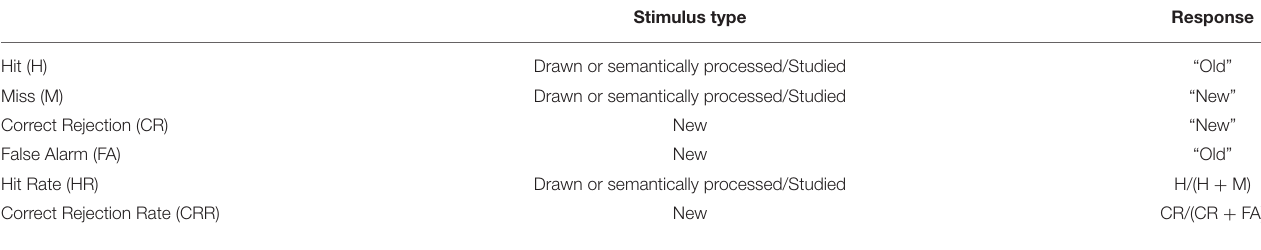
TABLE 1 | Overview of the different types of responses as a function of stimulus